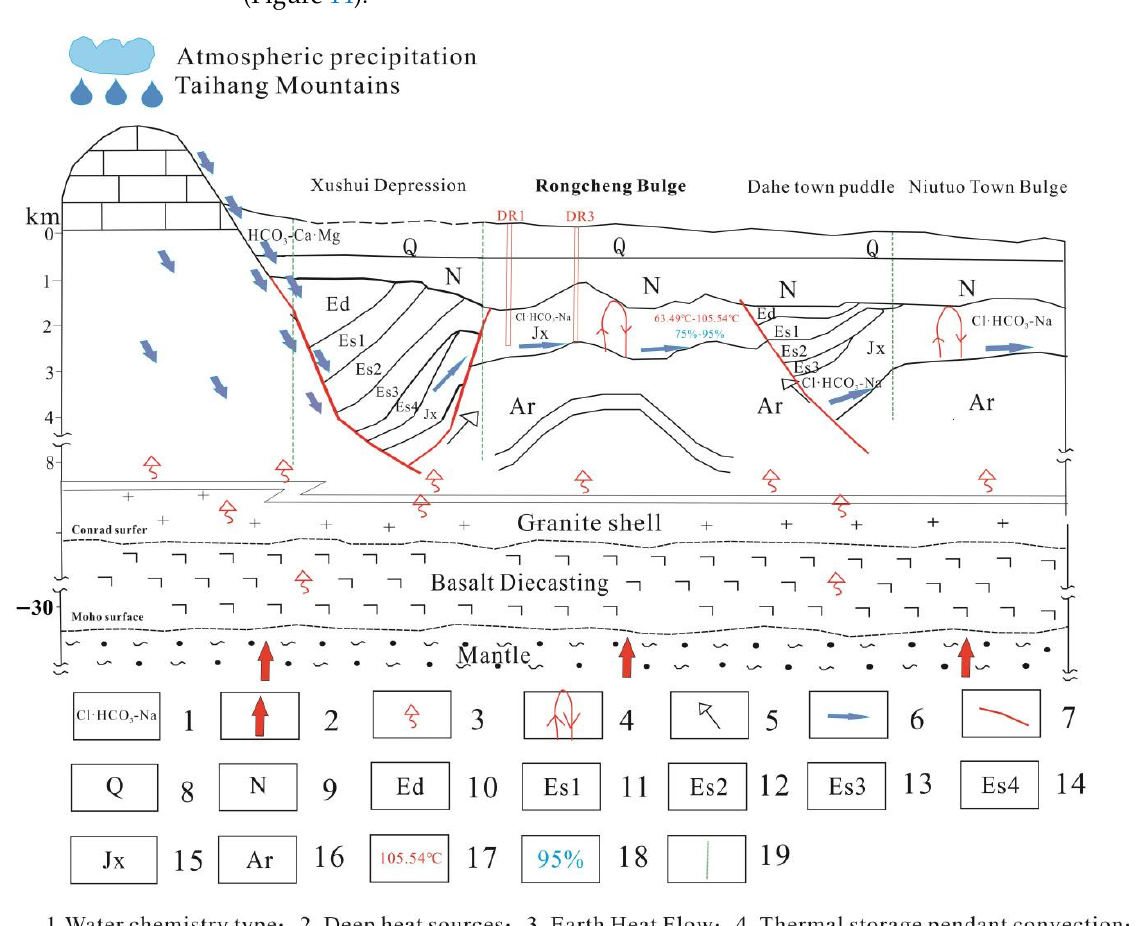
Figure 14. Schematic diagram of the Rongcheng Bulge geothermal system.